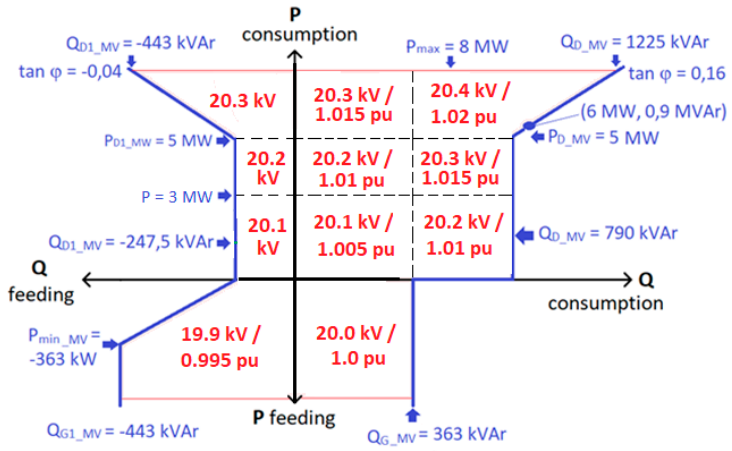
Figure 11. Real-time HV/MV substation PQ -flow dependent OLTC setting value with SSG (RPW)- limits.